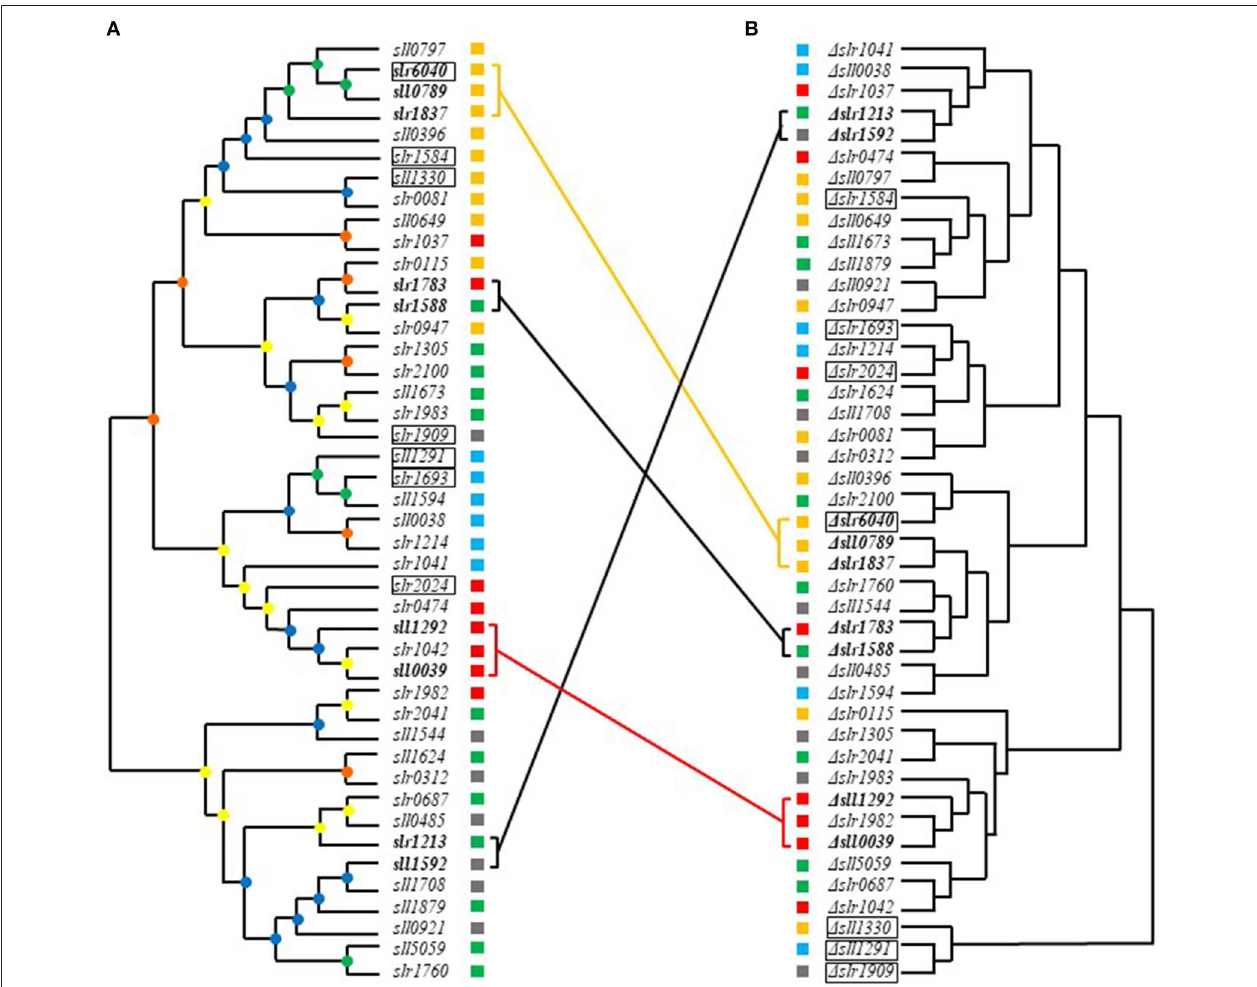
FIGURE 6 | Comparative analysis of metabolomics- and evolution-based trees of RRs. (A) Phylogenetic analysis of RRs based on the receiver domains. Different cube colors beside the gene names and mutants represent different subfamilies: gray for NarL family, yellow for OmpR family, red for CheY family, blue for PatA family and green for others, respectively. (B) Hierarchical clustering analysis based on metabolomic profiles. Different cube colors beside the gene names and mutants represent different subfamilies: gray for NarL family, yellow for OmpR family, red for CheY family, blue for PatA family and green for others, respectively. Four groups of RR genes that shared close relationship in both phylogenetic tree and metabolomics-based tree were marked in bold. Genes clustered in both metabolomics- and evolution-based trees were linked by lines with same colors of their subfamilies. The seven most regulated mutants were marked with black frame. The bootstrap values were represented in different colors of nodes: green for 1,000–750, blue for 750–500, yellow for 500–250, and orange for